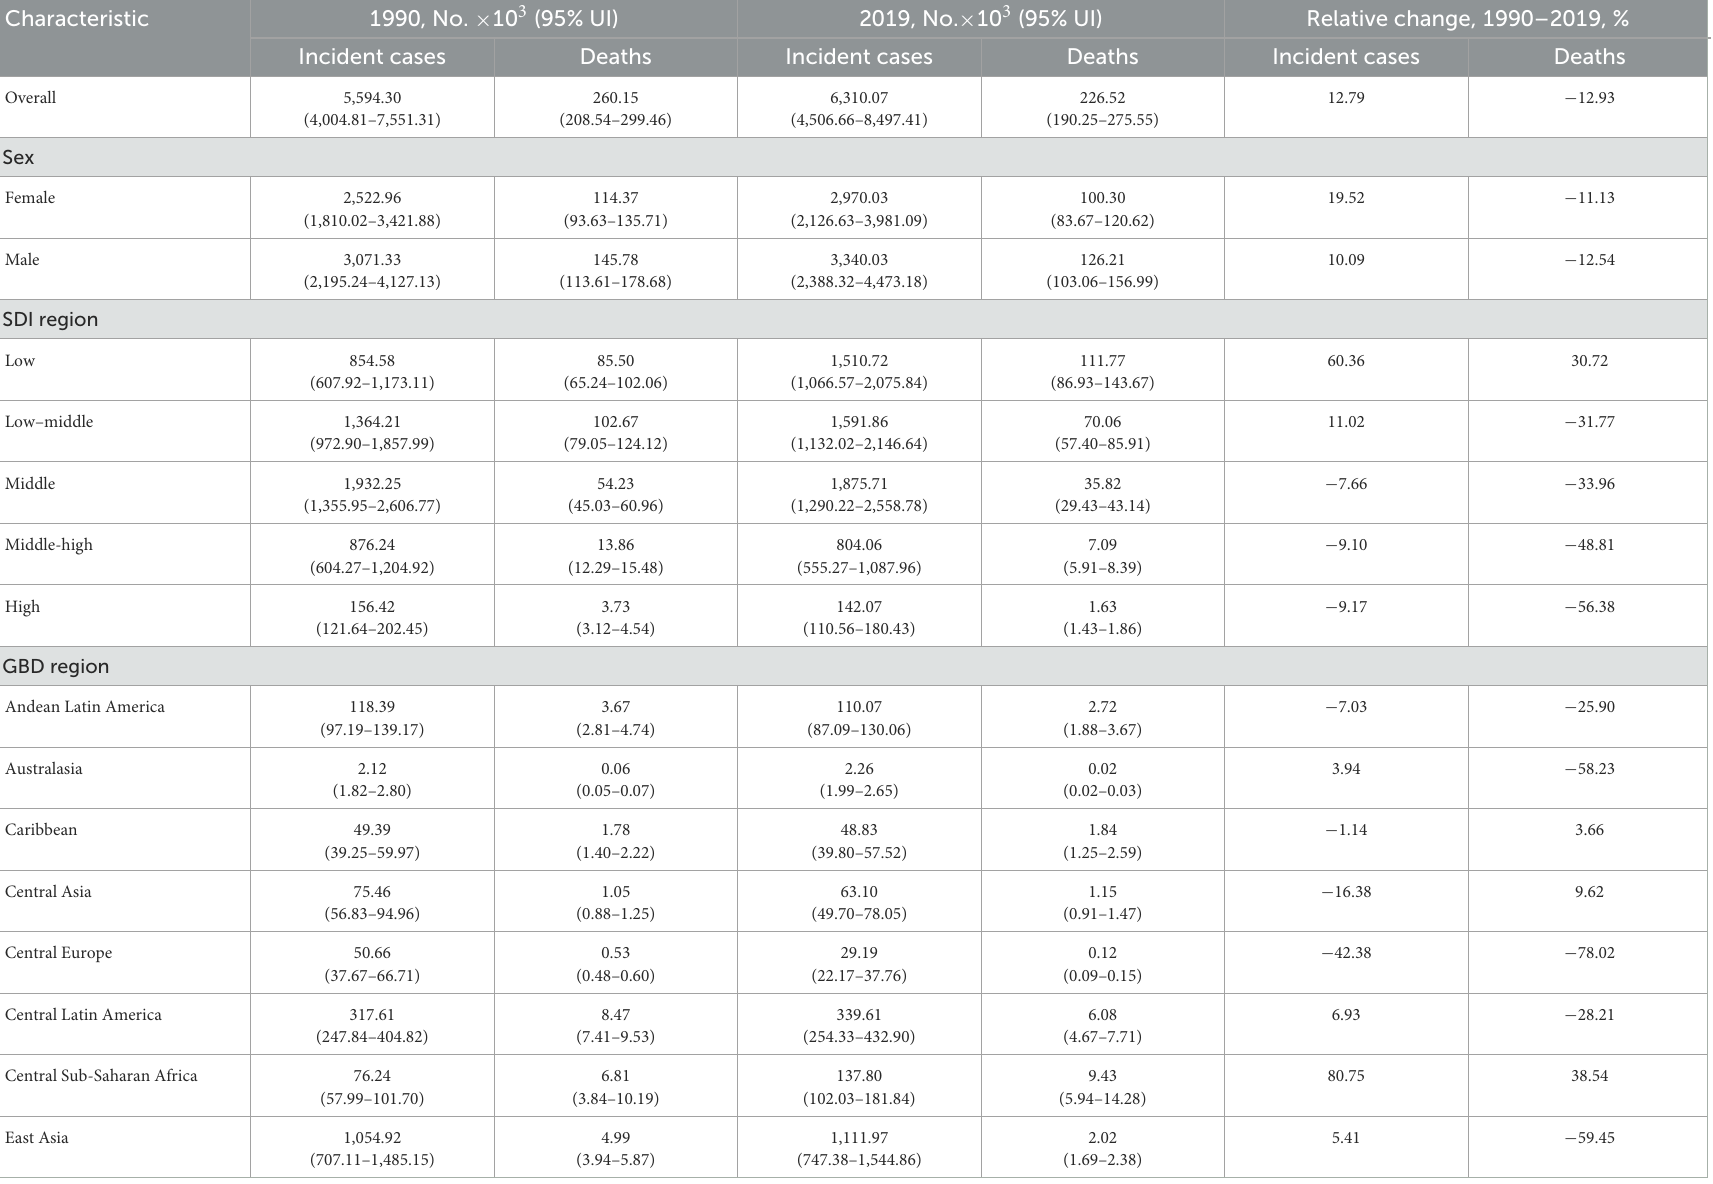
TABLE 1 Incident cases and deaths of NSNIs in 1990 and 2019 and their change trends from 1990 to 2019.